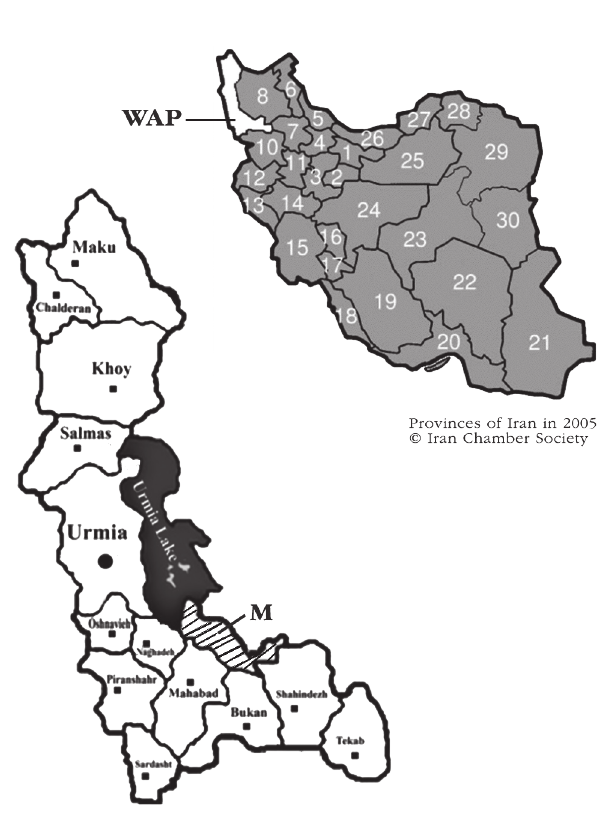
Fig. 1. – Geographical location of farms where animals sampled in northwestern Iran (M: Miandoab suburban; WAP: West Azerbaijan